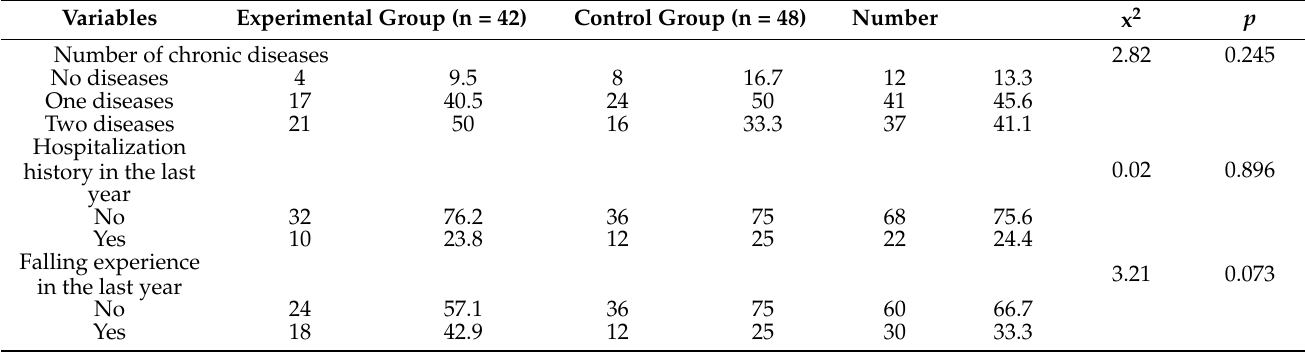
Table 2. The homogeneity of the biomarkers, and health beliefs between experimental and control groups in pre-test.